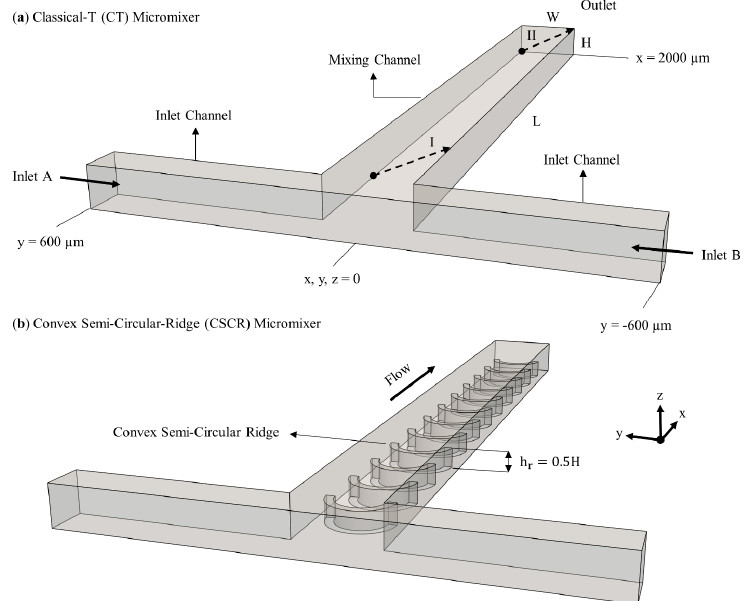
Figure 1. 3-D micromixer geometries ( a ) Classical-T (CT) micromixer; ( b ) Convex semi-circular-ridge (CSCR) micromixer. Diagonal dashed line arrows I and II are on the y - z plane at x = 100 and 2000 µm, respectively.